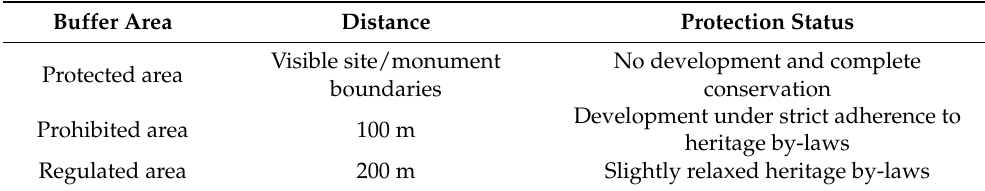
Table 1. Main buffer zones and protected areas for the conservation of archaeological and cultural heritage sites in South Asia (after [60]). Buffer Area Distance Visible